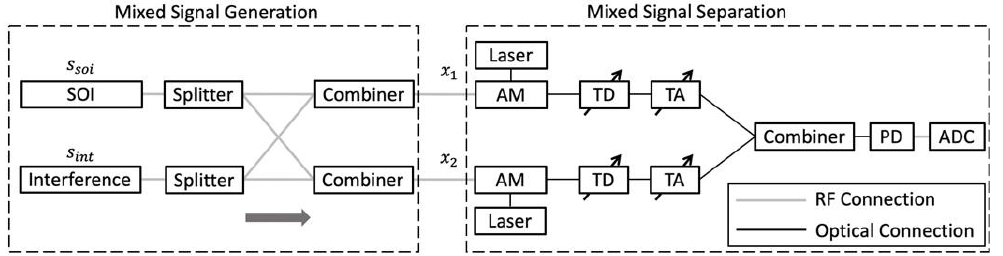
Figure 2. Experimental setup of the photonic interference cancellation circuit. (AM: optical amplitude modulator, TD: tunable optical delay, TA: tunable optical attenuator, PD: photon detector).